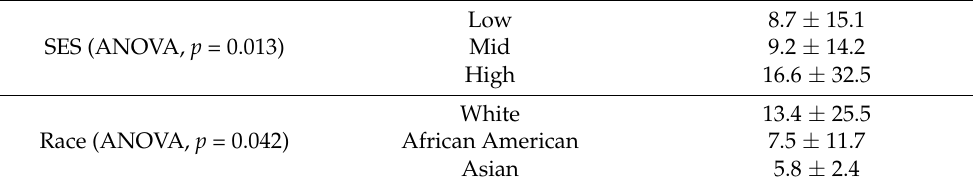
Table 3. Overall survival by SES or race. Overall survival (OS, in months, mean ± st. dev.) grouped by SES or race. The data demonstrate a significantly lower OS in subjects who live in a low- or mid-SES area compared to individuals who live in an area classified as having a high SES. Similarly, Whites have a significantly longer OS compared to other racial groups. Analysis of variance (ANOVA) was performed to detect significant